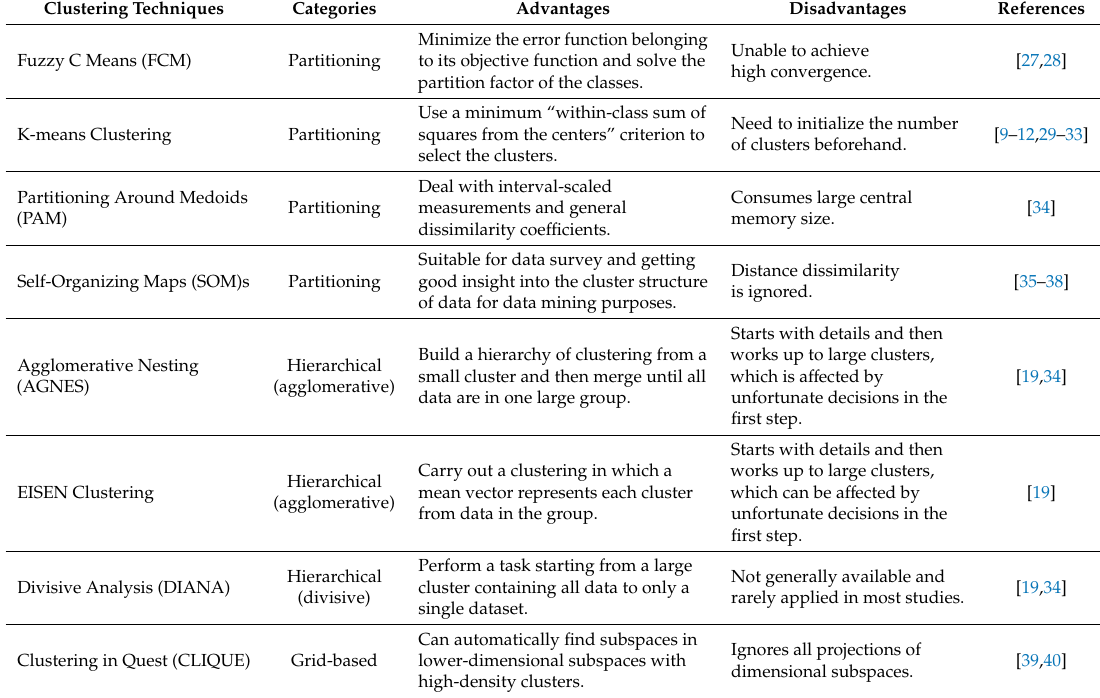
Table 2. Examples of popular clustering techniques along with their advantages and